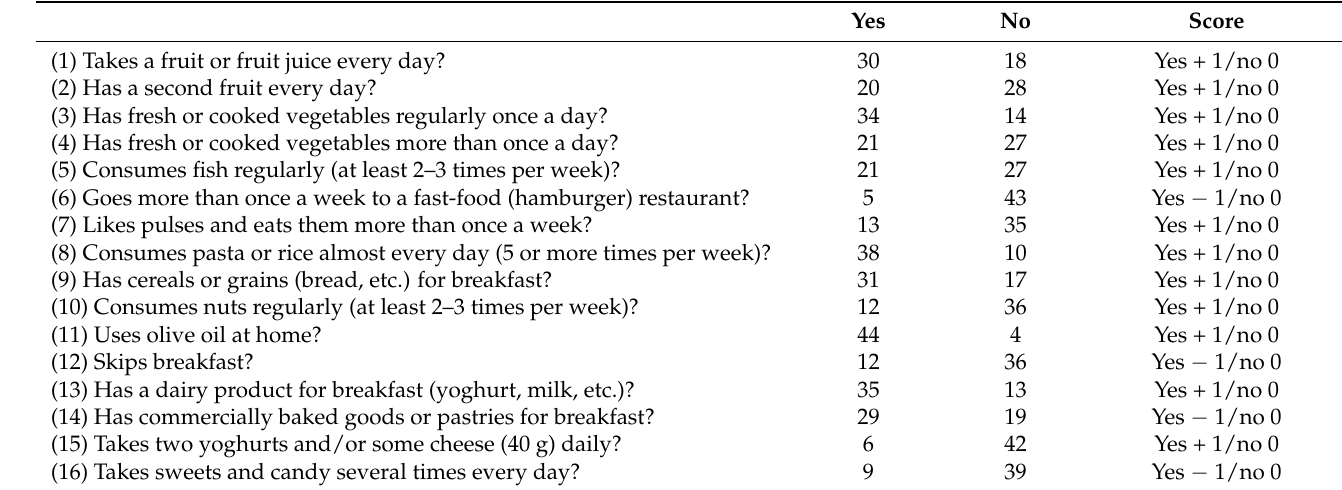
Table 2. Number of patients and responses (Yes/No) to the Kidmed questionnaire.